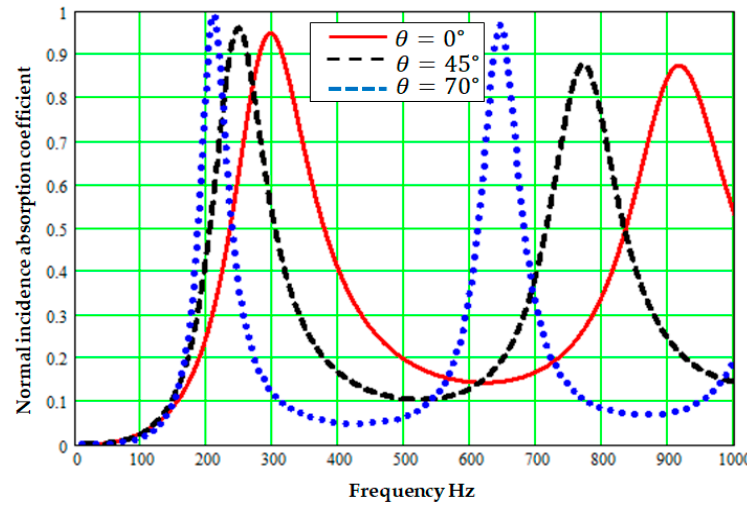
Figure 9. Normal incidence absorption coefficient spectra predicted for an alternating-width vertical-wall labyrinthine perforation ( w = 2 mm, b = 4.5 mm, l = 41 mm, δ = 6, N = 6) in a 0.05 m thick hard-backed micro-slit matrix (porosity 0.1, 0.4 mm wide slits) in which tortuosity is varied through slit inclination at 0 ◦ (continuous line) or 45 ◦ (broken line) or 70 ◦ (dotted line) to the normal.